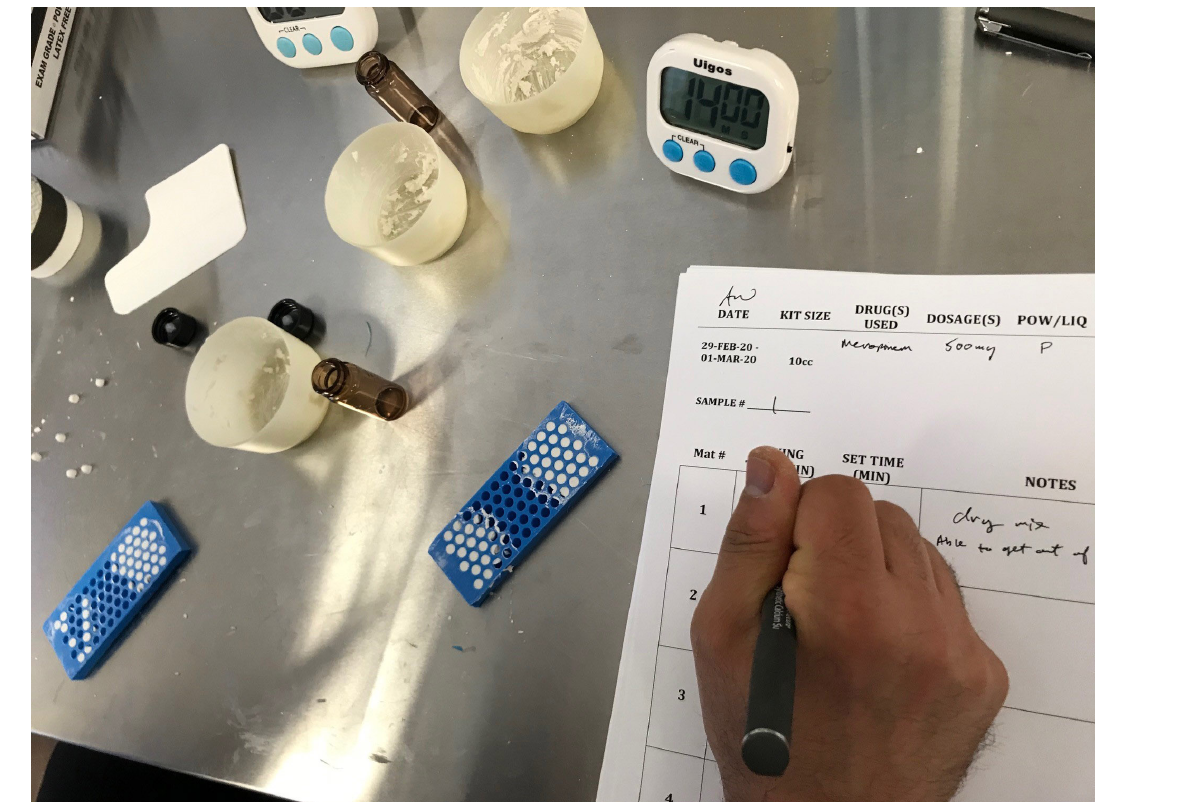
Figure 1. Photograph of 4.8mm bead mat. The antimicrobial-loaded CaSO 4 paste is shown after spreading the paste into the molds. Once applied, the bead mats were left on the countertop to set, in order to imitate operating room procedure. Time measurements were recorded to establish a set time for each